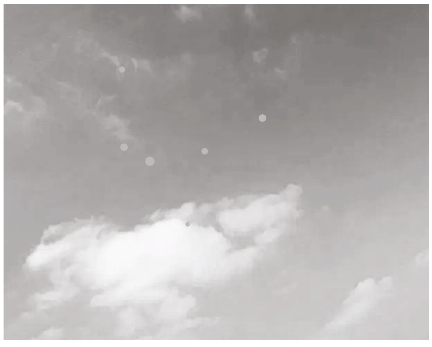
Figure 1: Original image. Figure 2: Reference [8] noise reduction results of multimodel e ffi cient particle fi lter.